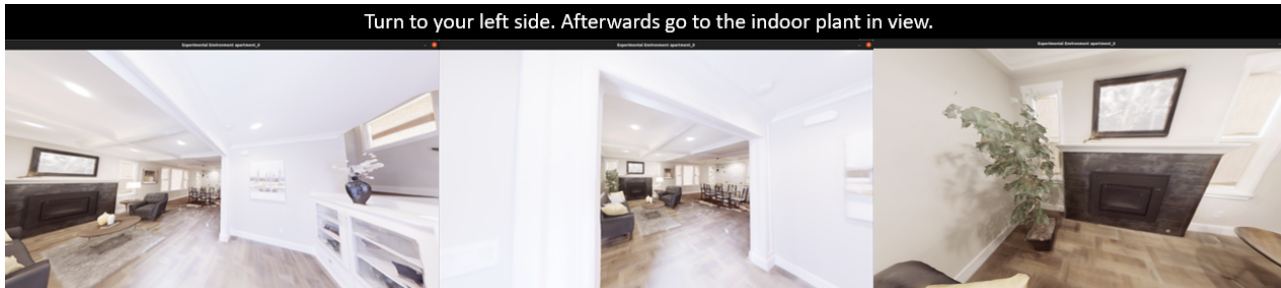
Figure 4. ( Left ) actual position, segment starts here, instruction is received; ( Middle ) the first part of the instruction is executed; ( Right ) the second part is executed, the segment is